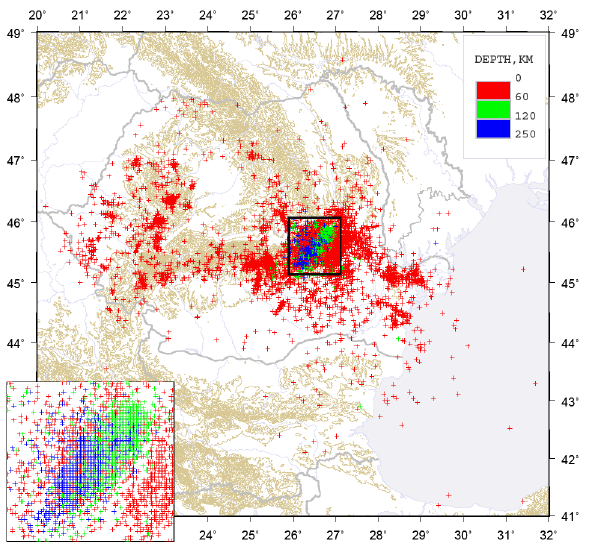
Fig. 1. Map of the seismicity of Vrancea from 1978 to 2008.